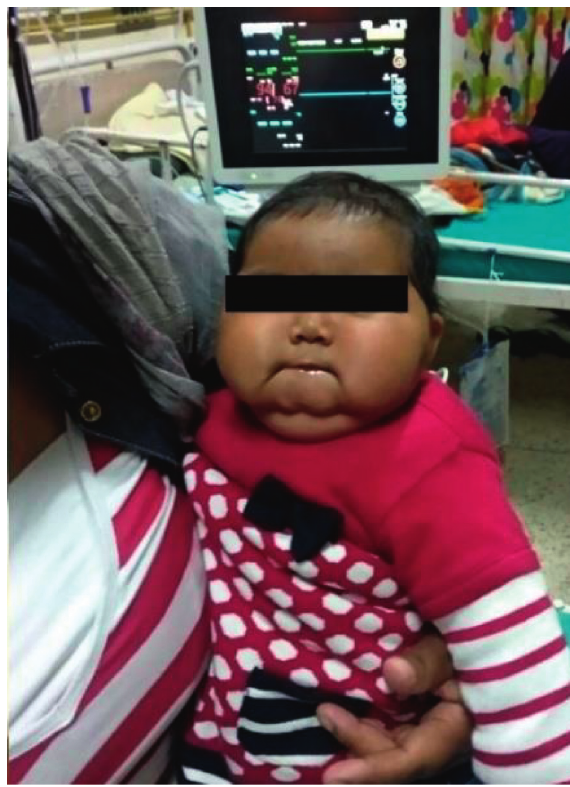
Figure 1: Moon facies of the child.